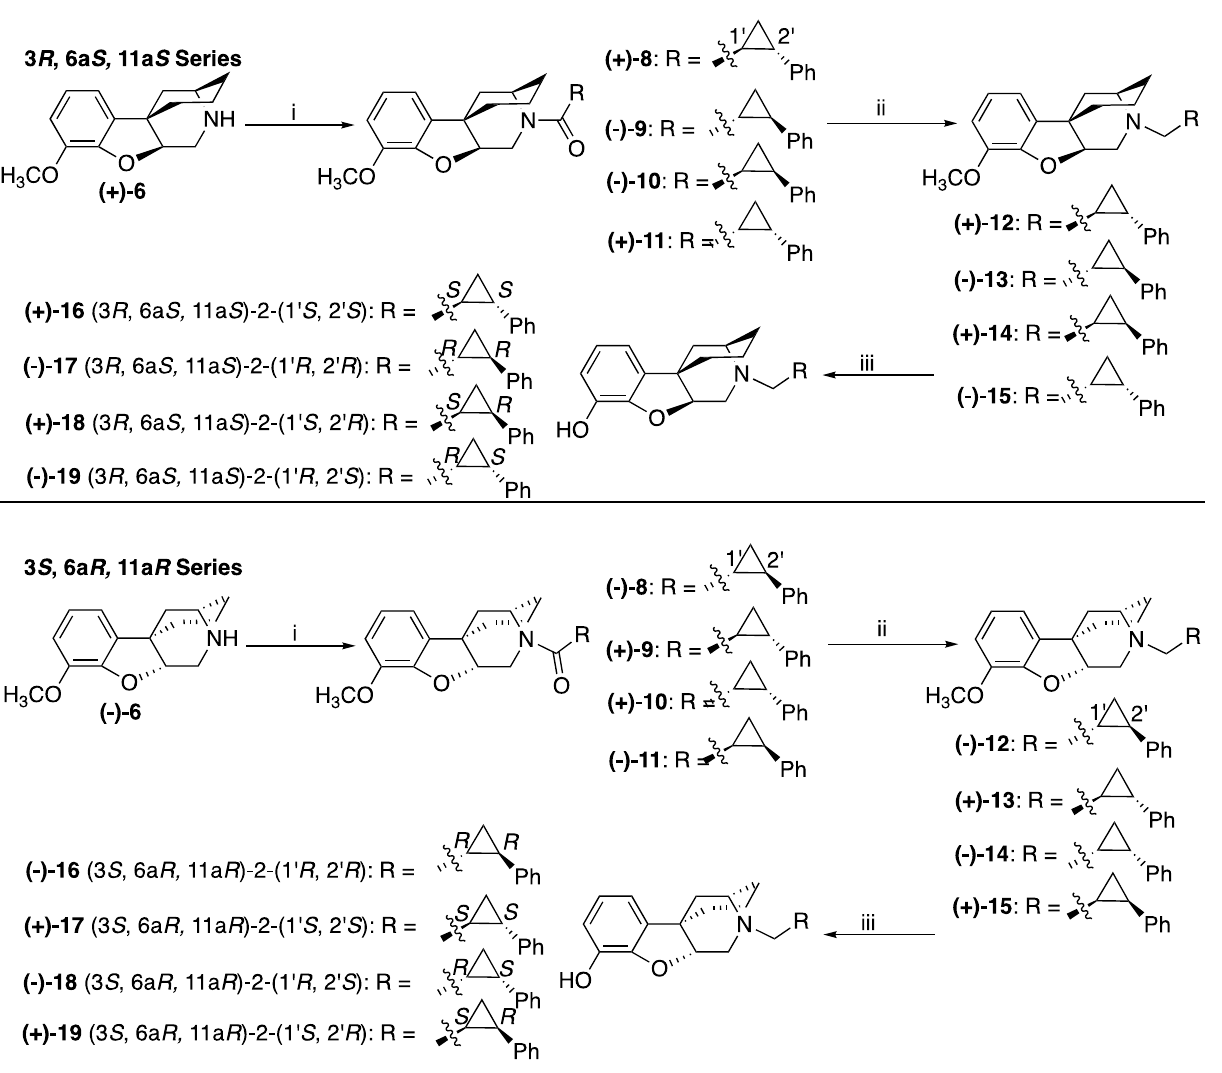
Scheme 3. Synthesis of the N -(2-phenylcyclopropyl)methyl enantiomers of (+)- and (-)-